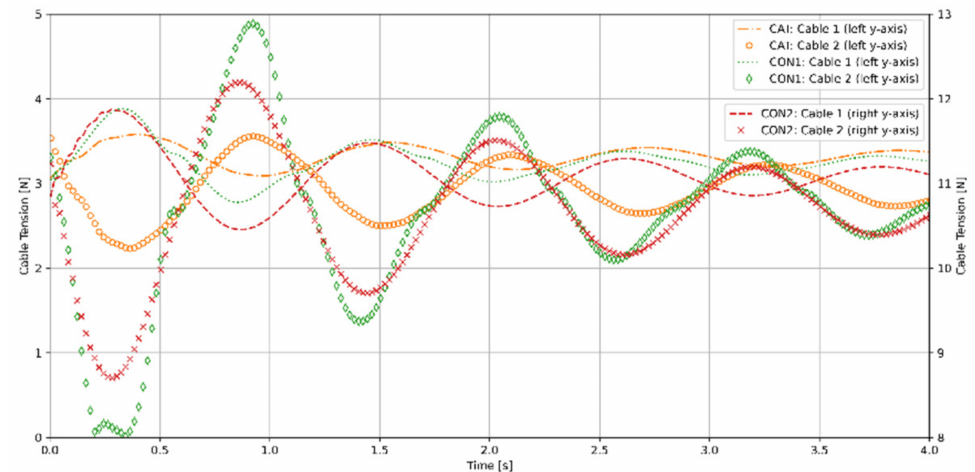
Figure 14. Comparative time histories of mooring tensions for decay tests in pitch.